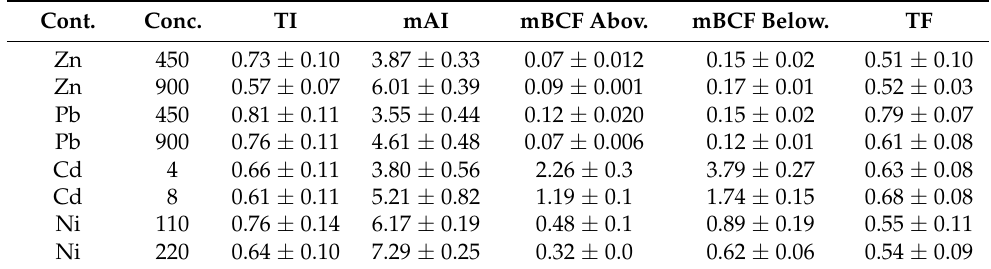
Cont. Conc. TI mAI mBCF Abov. mBCF Below.